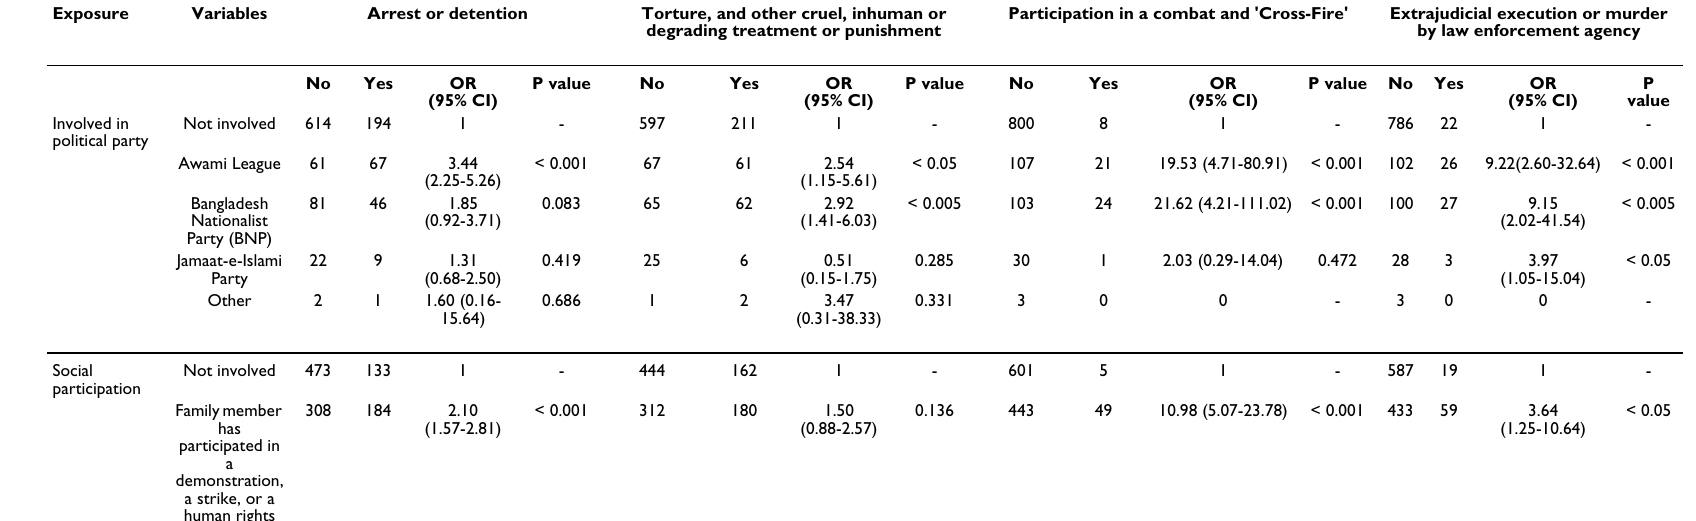
Participation in a combat and 'Cross-Fire' Extrajudicial execution or murder degrading treatment or punishment by law enforcement